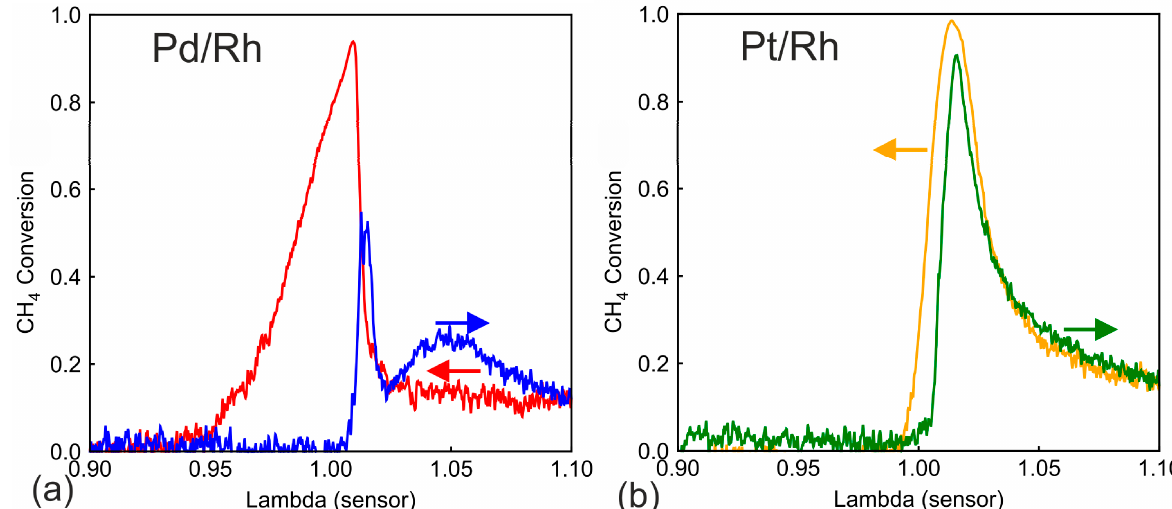
Figure 2. CH 4 conversion of the ( a ) Pd/Rh ( b ) Pt/Rh catalyst during λ ramp-up (blue and green) and ramp-down (red and yellow) at 520 °C.